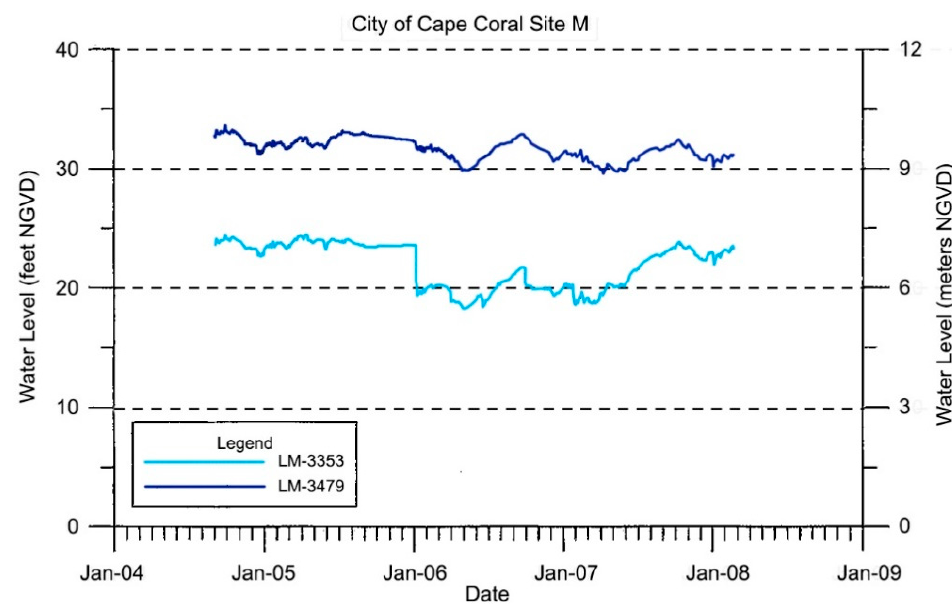
Figure 10. Water level data from two monitoring wells, located in the southern part of the City. Note that the water levels fluctuate on a seasonal basis caused by variation in wellfield pumping, but there is no downward trend in water levels.